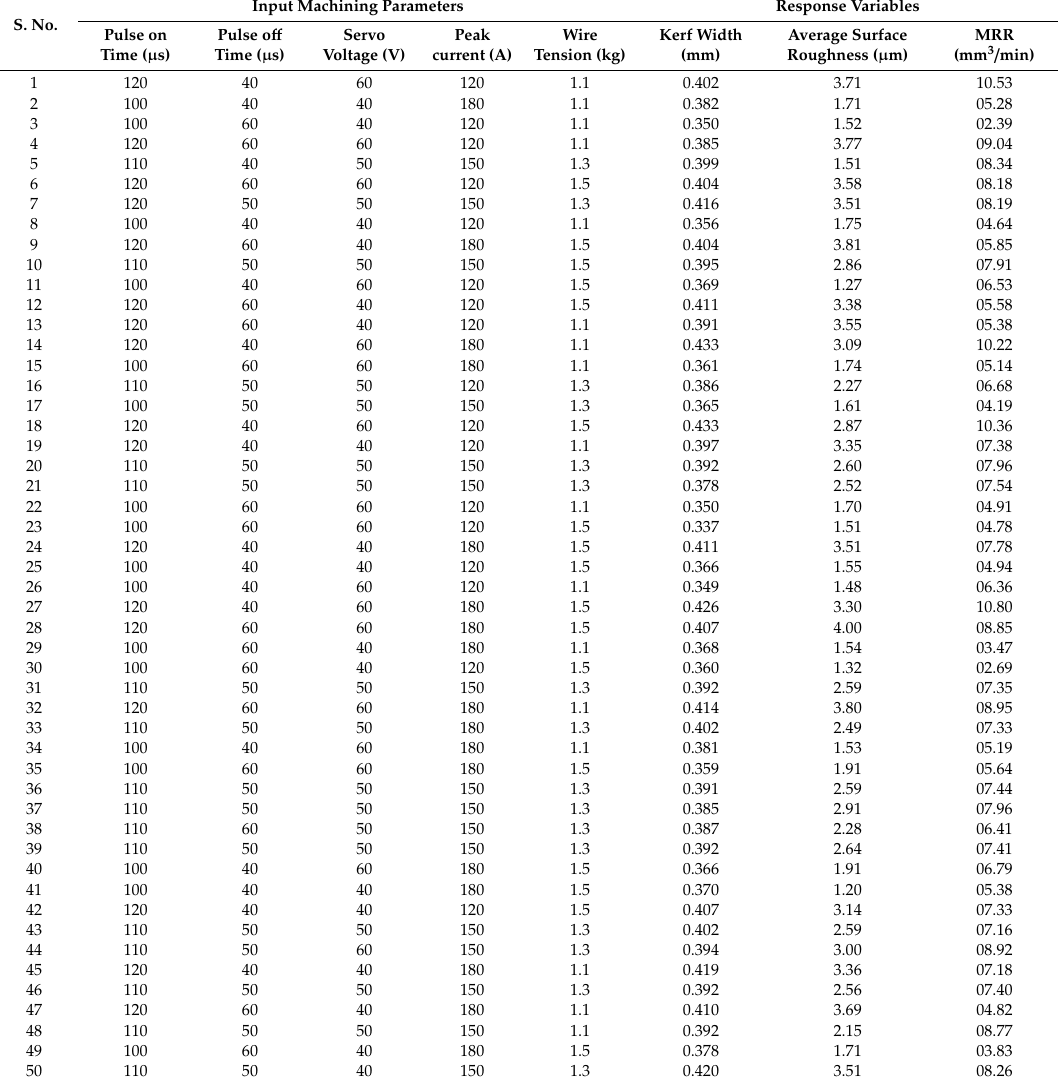
Table 4. Experimental plan with chosen input machining parameters and measured response